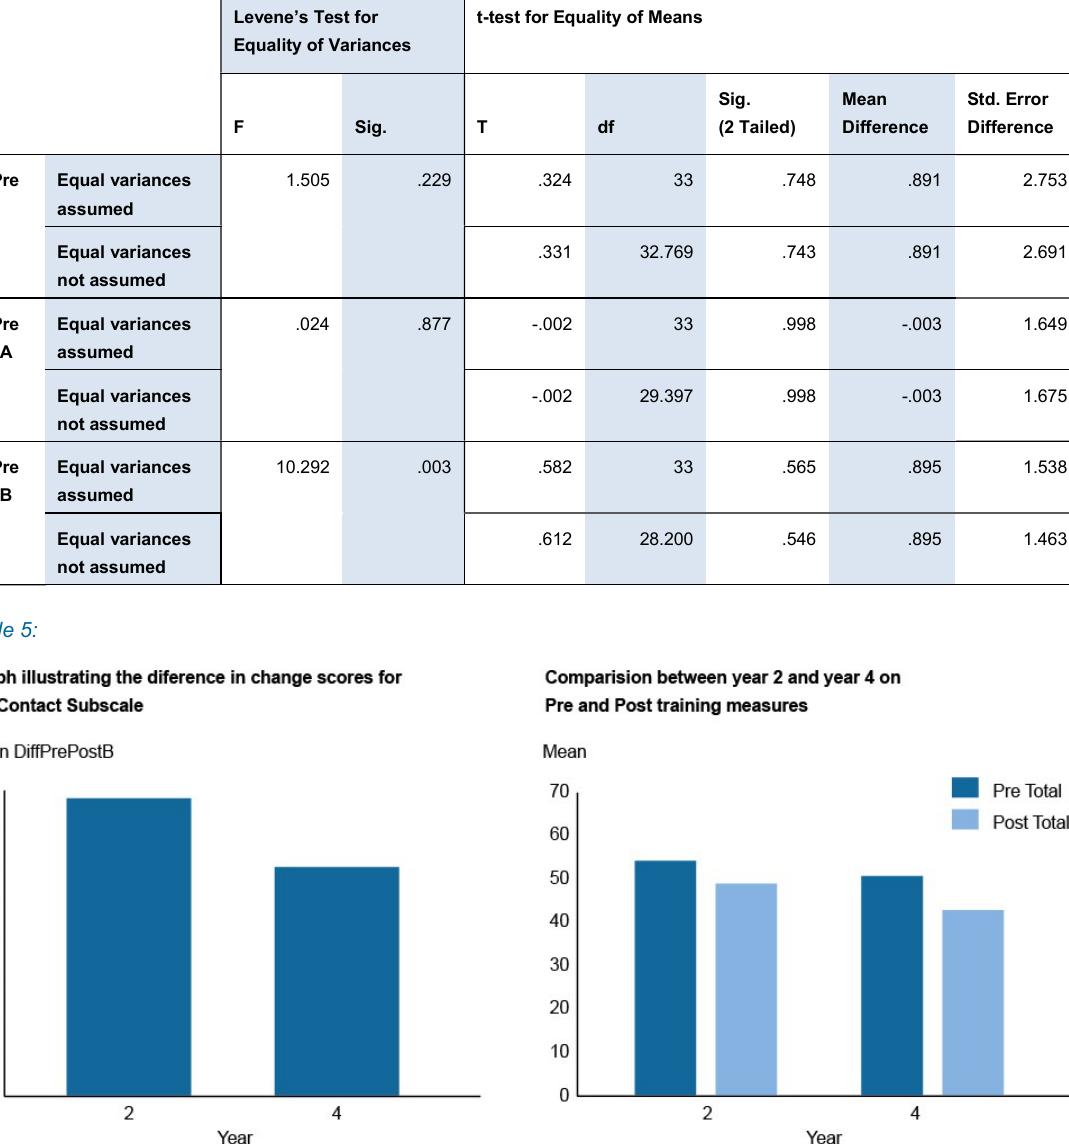
Table 4: Independent Samples Test